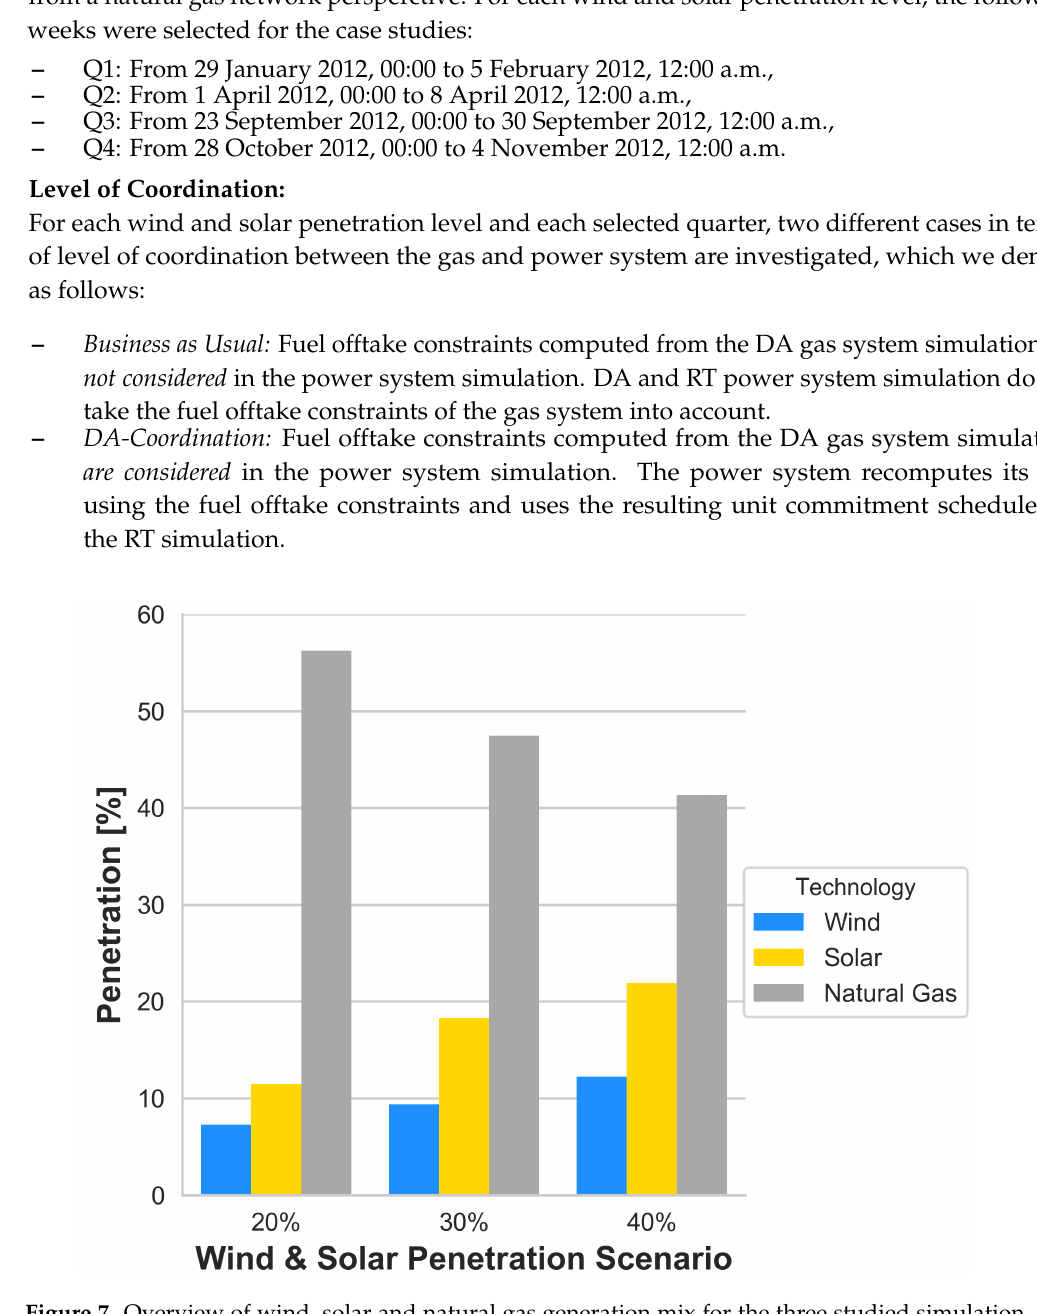
Figure 7. Overview of wind, solar and natural gas generation mix for the three studied simulation cases considering only the four selected weeks (one per